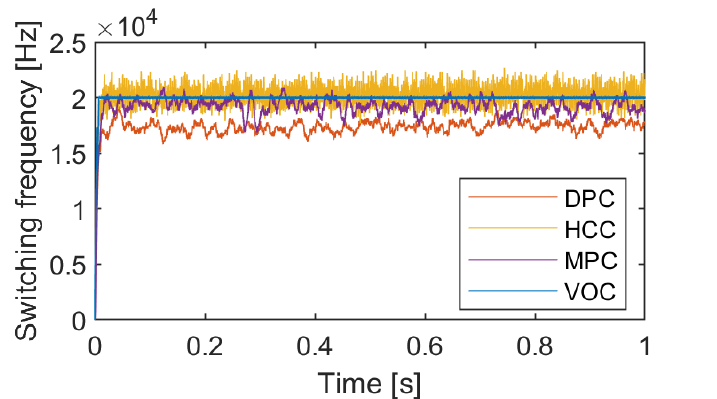
Figure 33. The switching frequency for different control systems.